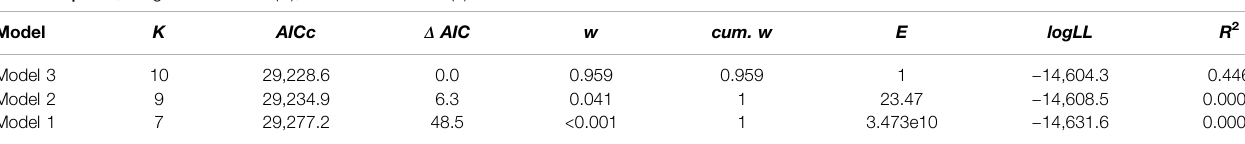
TABLE 2 | AICc, weight of evidence ( w ), and evidence ratio (E).